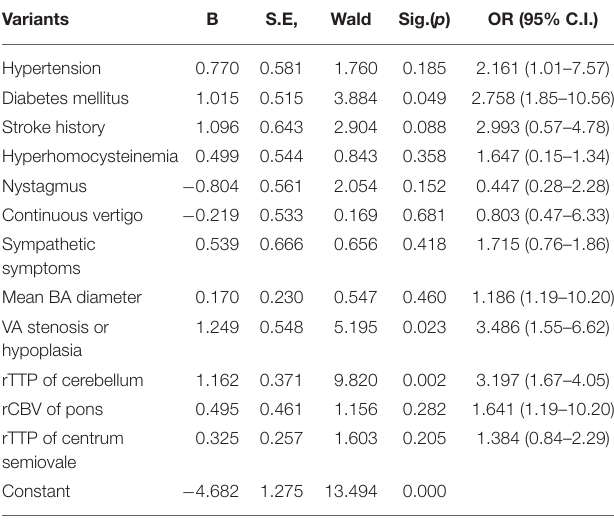
TABLE 4 | Multivariate logistic regression analysis for stroke in patients with isolated vertigo ( n = 157).